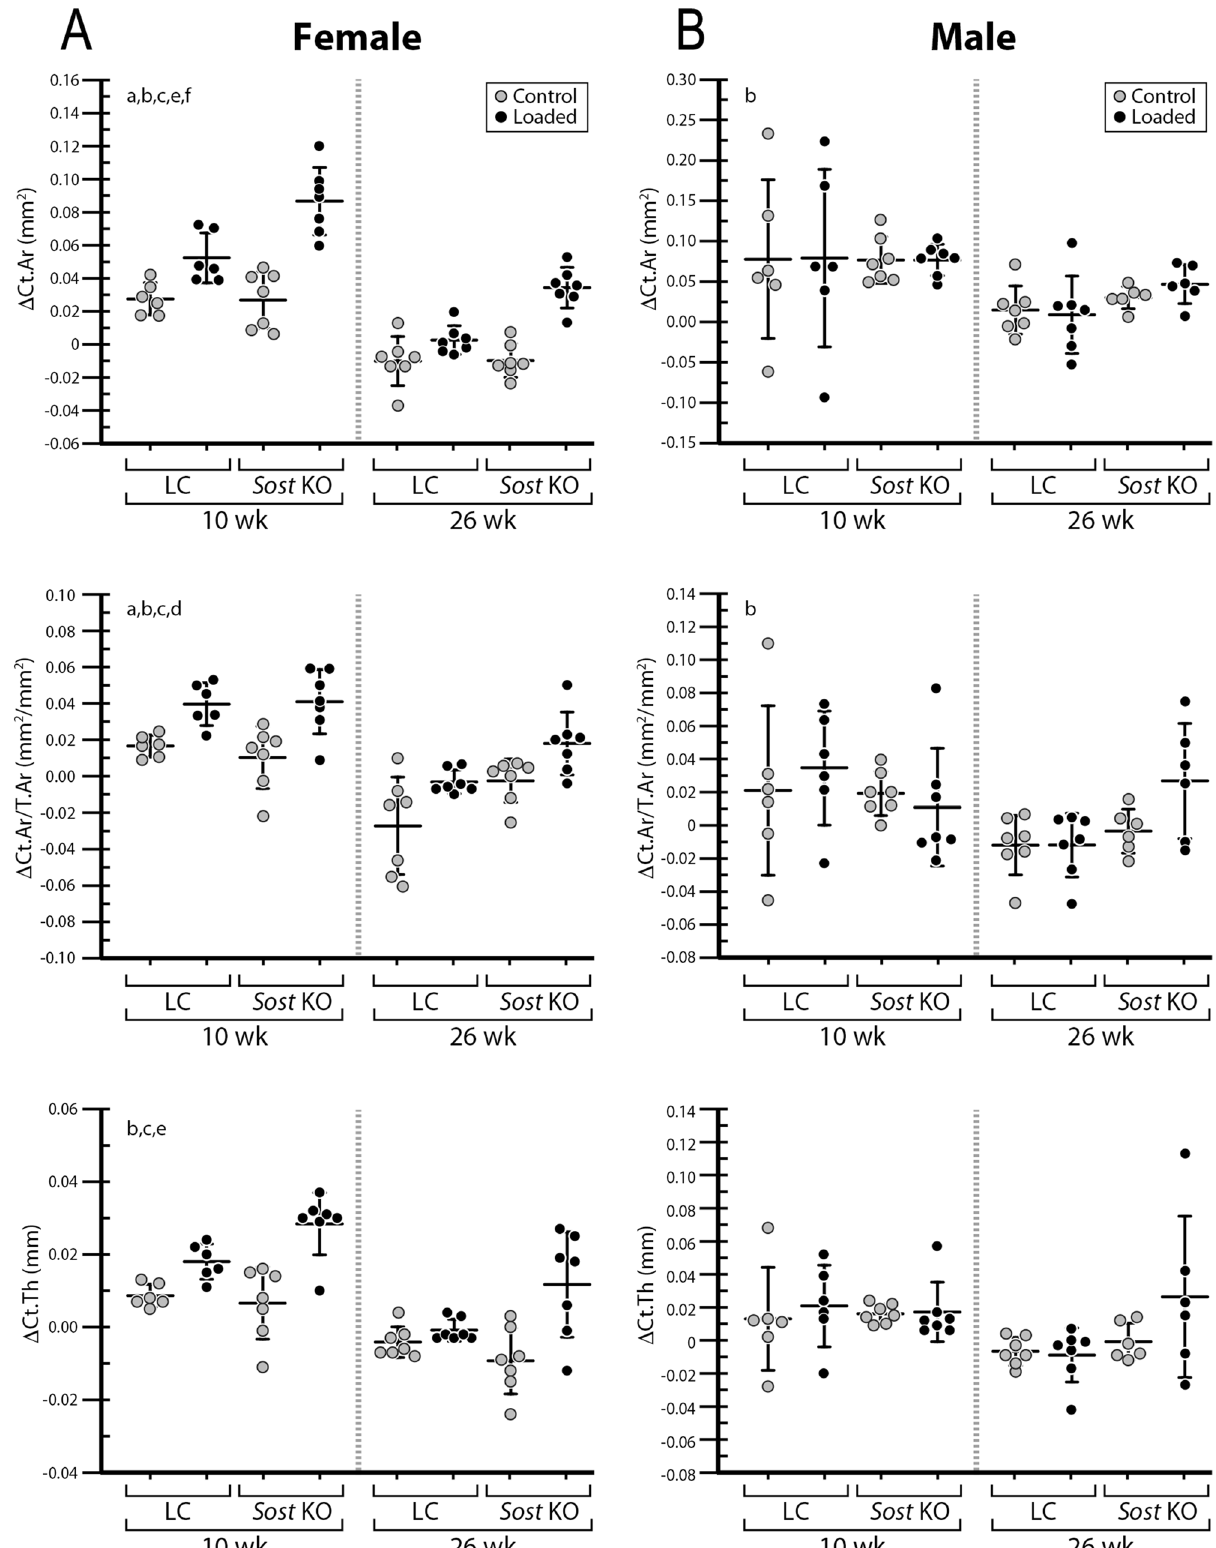
Figure 8. MicroCT results of cortical area (ΔCt.Ar), cortical area divided by total area (ΔCt.Ar/T.Ar) and cortical thickness (ΔCt.Th) by in vivo microCT expressed as (ΔX = X day15 − X day0 within the same limb). Previously published data in female 10- and 26-week-old LC and Sost KO mice are shown here for comparison with male mice 10 . ANOVA: indicates an effect of (a) genotype, (b) age, (c) loading, (d) genotype and age, (e) genotype and loading, (f) age & loading, p < 0.05. Sample size: 10-week-old LC (male = 6, female = 6), 10-week-old Sost KO (male = 7, female = 7), 26-week-old LC (male = 7, female = 7), 26-week-old Sost KO (male = 6, female =